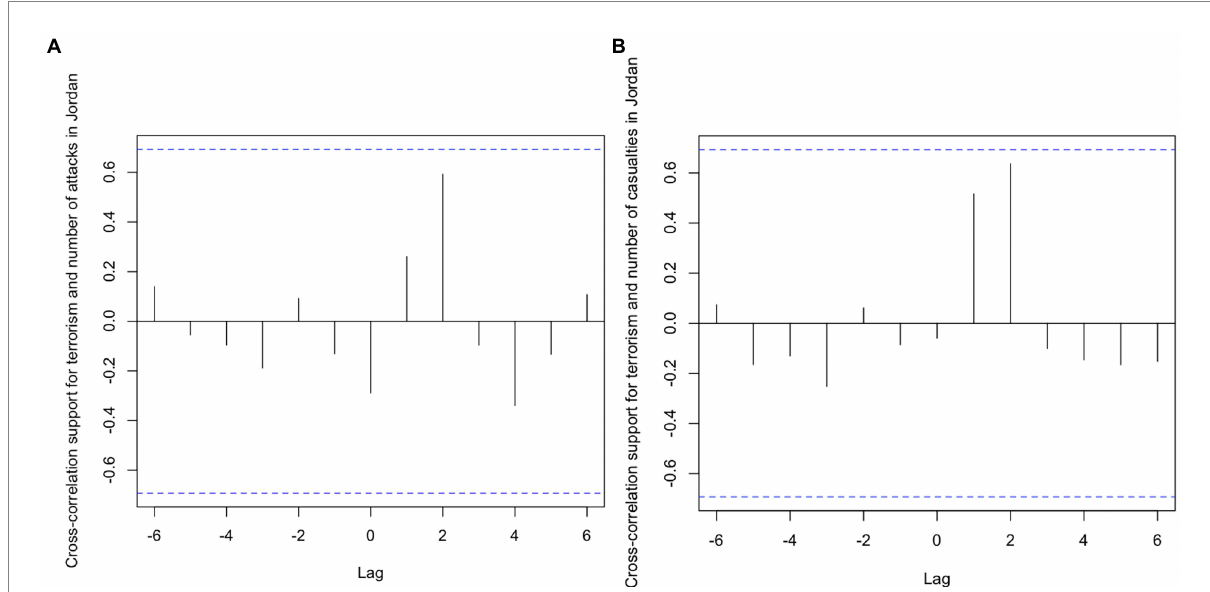
FIGURE 6 Cross-correlation function of time-series “Terrorism is ever justified” and “Number of attacks” Panel (A) as well as “Casualties in Jordan” Panel (B) .